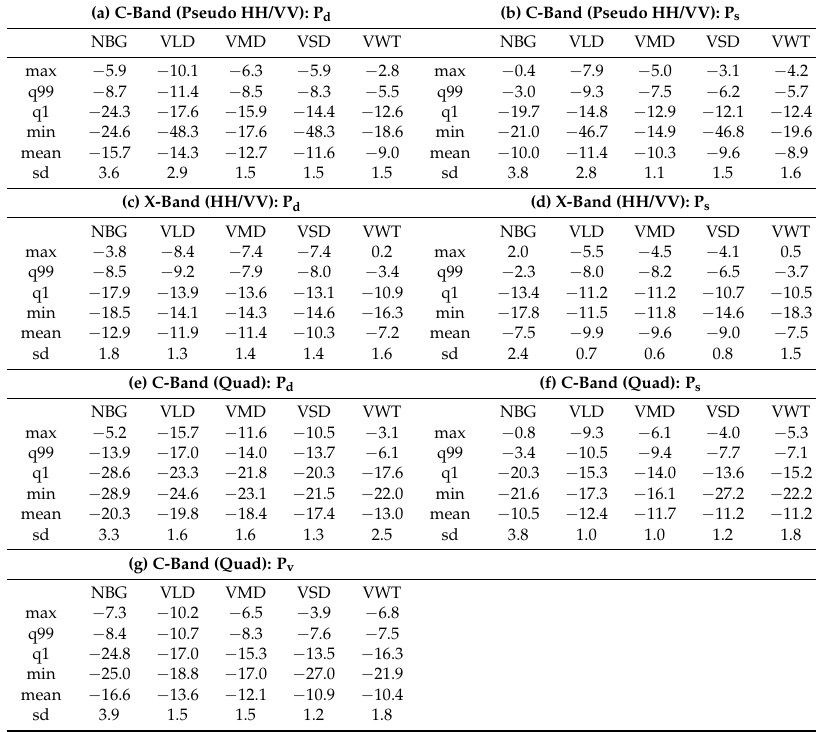
Table 4. Descriptive statistics—maximum (max), 99% quantile (q99), 1% quantile (q1), minimum (min), mean and standard deviation (sd)—of the investigated features double bounce (P d ), surface scattering (P s ) and volume scattering (P v ) for none-water land cover classes (NBG, VLD, VMD, VSD, VWT) and for C-Band R-2 and X-Band TSX/TDX data. The data show the average of the three test sites Richards Island (RIS), Tuktoyaktuk (TUK) and East Channel (ECH) in the unit decibel